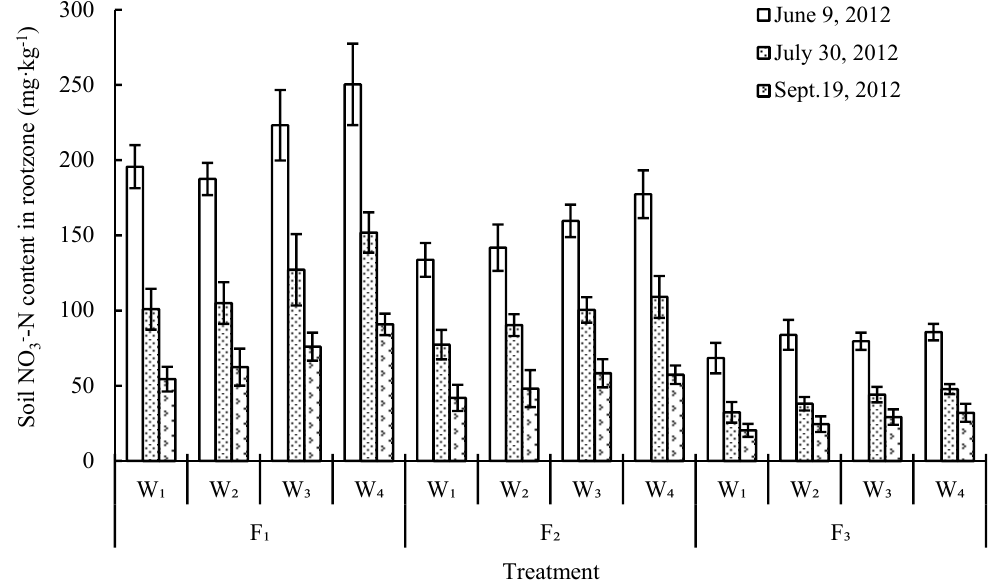
Figure 3. E ff ects of di ff erent water and fertilizer treatments on soil NO 3 − -N content in rootzone Figure 3. Effects of different water and fertilizer treatments on soil NO3 ‐ ‐ N content in rootzone (40~60 (40~60 cm) of young apple trees on 9 June, 30 July and 19 September in cm) of young apple trees on June 9th, July 30th and September 19th in 2012.